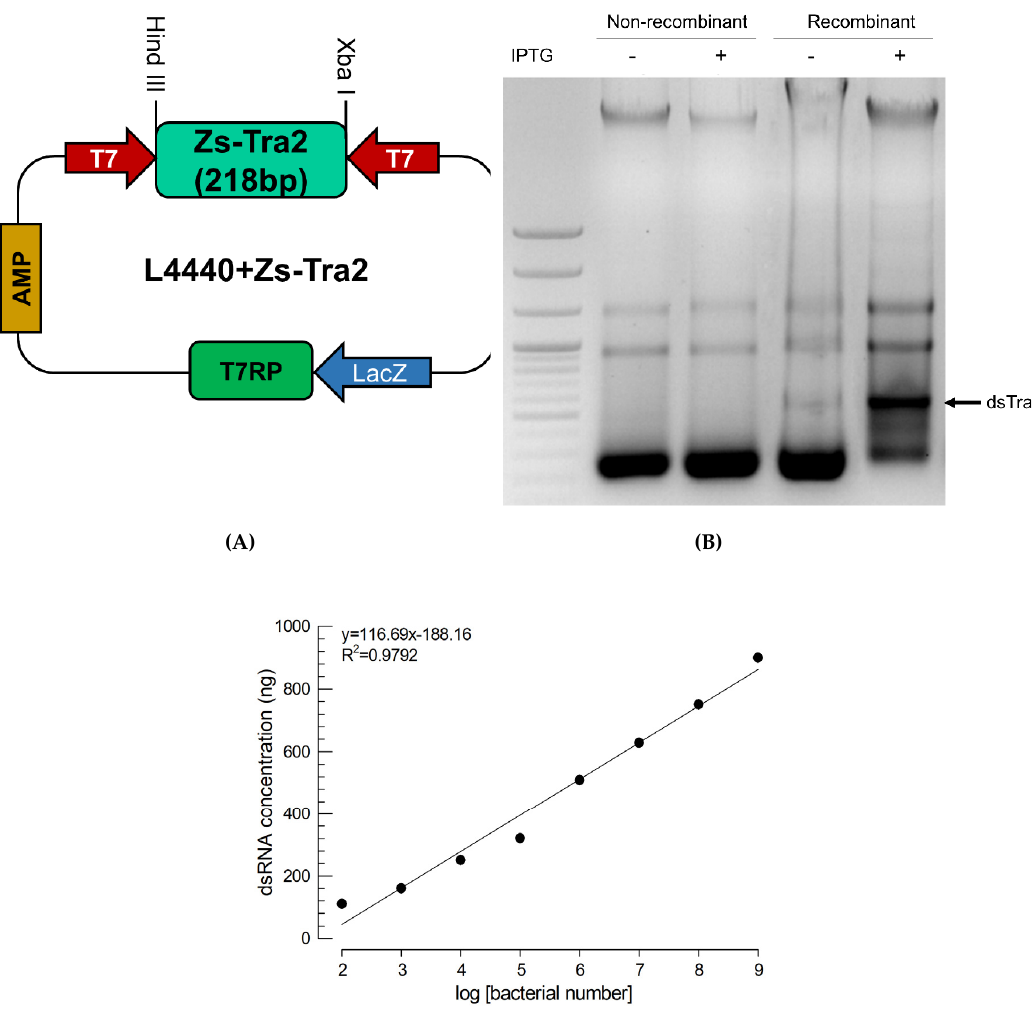
Figure 5. Recombinant E. coli expressing dsRNA ( dsTra2 ) specific to Zs-Tra2 . ( A ) Cloning of a fragment of Zs-Tra2 into an expression vector of L4440 using Hind III and Xba I multiple cloning sites. After selecting transformed cells using ampicillin (‘AMP’) medium, T7 RNA polymerase (‘T7 RP’) was overexpressed by IPTG inducer on lactose promoter (‘LacZ’). Partial Zs-Tra2 RNA is transcribed by two opposite T7 promoters (‘T7’). ( B ) Confirmation of dsTra2 production specifically in recombinant E. coli under IPTG induction. ( C ) Regression analysis of dsTra2 amounts from bacterial cell numbers. The extracted dsRNA was quantified by band intensity based on a standard curve using known amounts of dsRNA prepared by in vitro construction method. Each point represents an average obtained from three replications.